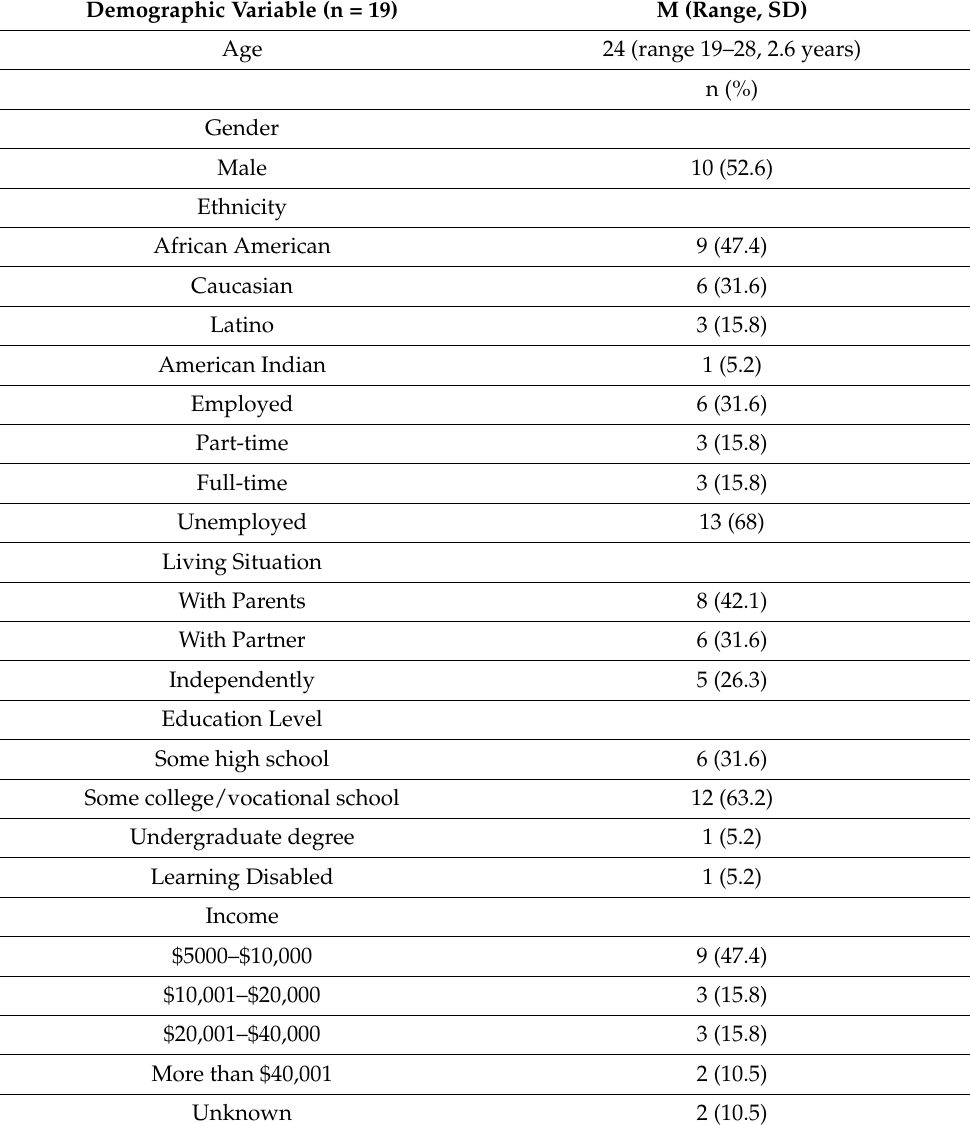
Table 1. Participant Demographic